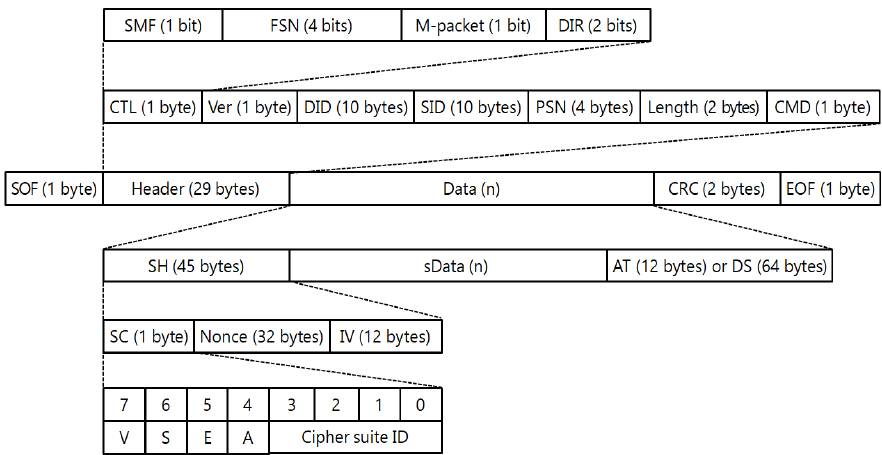
Figure 2. Protocol structure between data concentrator unit and AMI head-end system.